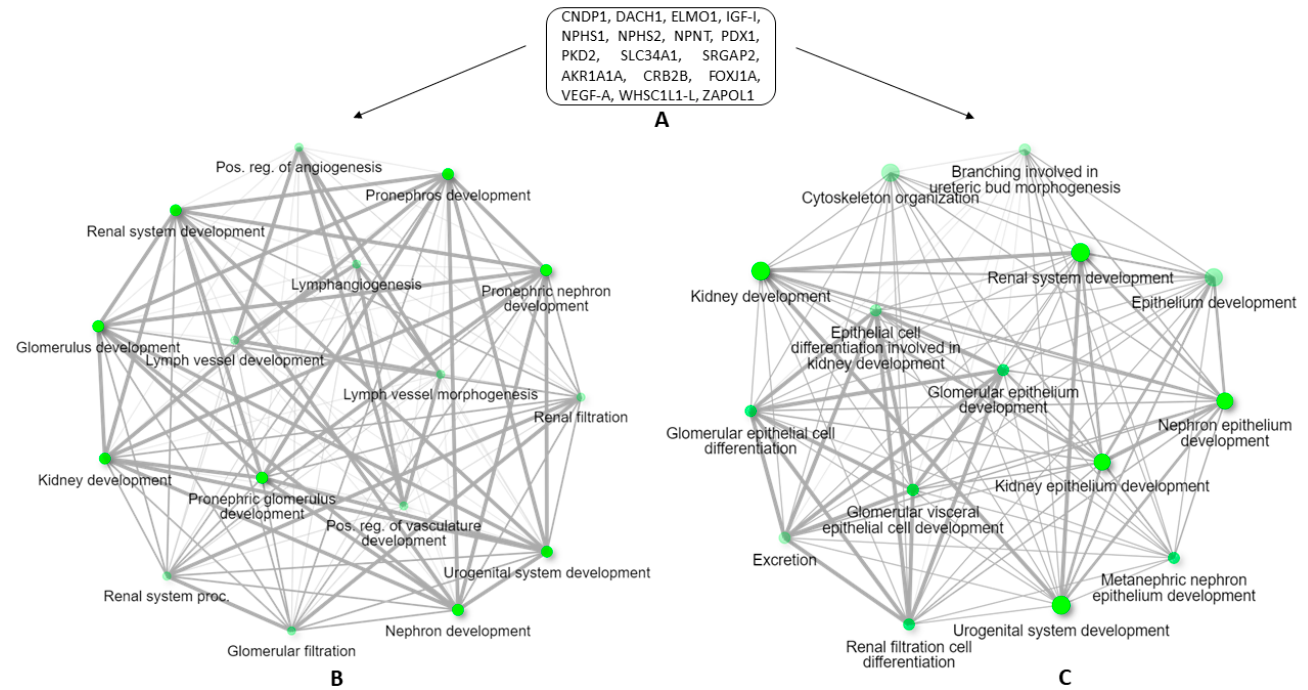
Figure 2. Significantly enriched gene ontology of biological processes corresponding to the DN associated genes in zebrafish. List of genes (Table 1) studied in DN using zebrafish model ( A ); the figure further depicts the biological processes these genes are involved in in zebrafish ( B ), human ( C ). Darker nodes (dot) are more significantly enriched gene sets. Bigger nodes represent larger gene sets. Thicker edges (line) represent more overlapped genes. For the visualization, we used graphical gene-set enrichment tool ShinyGO [17].